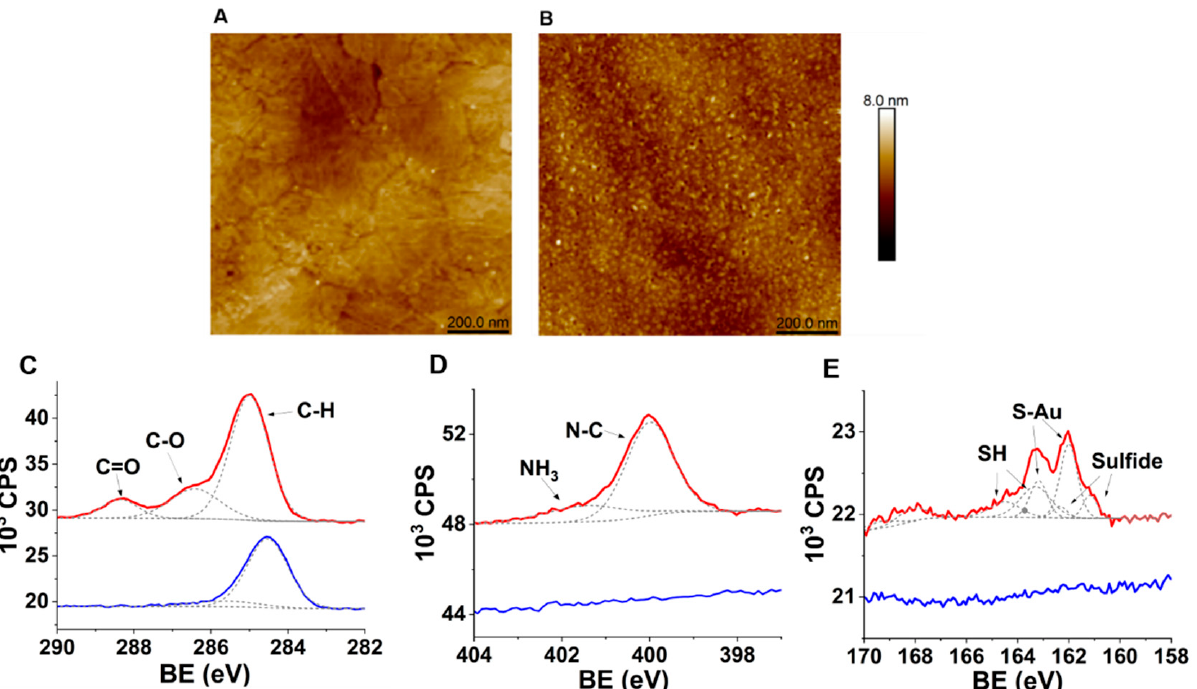
Figure 3. Characterization of Au-CFK surfaces. Upper panel: AFM analysis of the modified gold substrates. ( A ) Bare gold (Ra = 0.26nm); ( B ) after-adsorption CFK random peptide mixtures (Ra = 0.31 nm). Lower panel: XPS spectra of CFK-Au surface: ( C ) C 1s BE region; ( D ) N 1s BE region; ( E ) S 2p BE region (red lines) and bare Au surface (blue lines). Recorded data are shown with lines, and the Gaussian fit is shown with dashed lines .